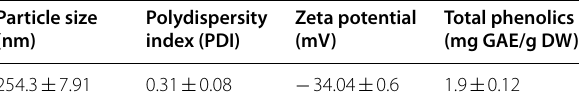
and phytochemical characteristics of